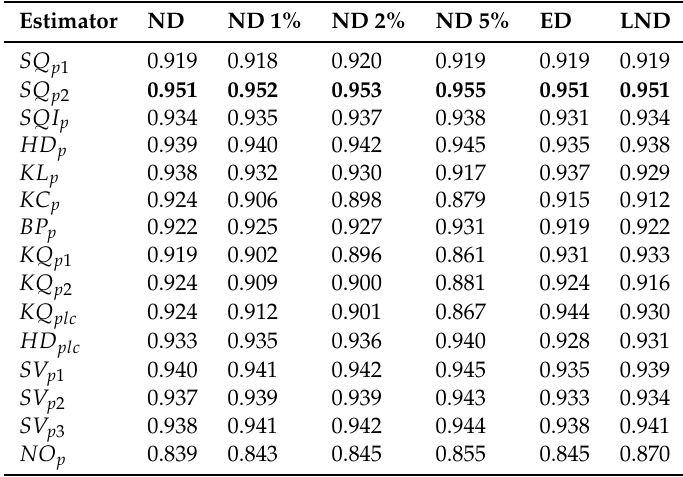
Table 2. Coverage probabilities for nonparametric Limits of Agreement ( n = 50). Bold figures indicate coverage probabilities exceeding the nominal level of 0.95.